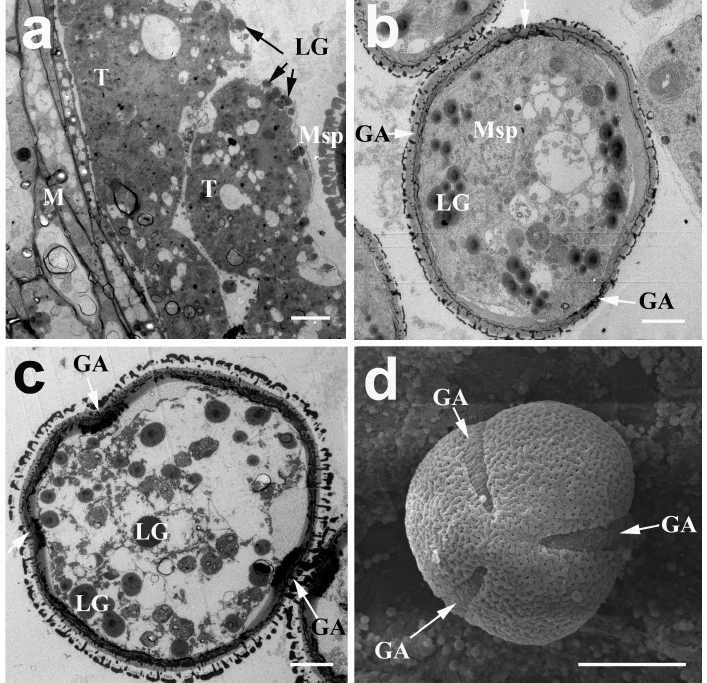
Figure 4. Transmission electron micrographs ( a – c ) and scanning electron micrographs ( d ) of the microspore and tapetum of N. nucifera ‘Honghu Hong’. ( a ) Numerous lipid granules were secreted from tapetum to the locule at the late young microspore stage. ( b ) Microspore at the middle young microspore stage. ( c ) Microspore at the late young microspore stage. ( d ) Microspore at the mature pollen stage. The arrows indicate the germination apertures in ( b – d ). GA, germination aperture; LG, lipid granule; M, middle layer; Msp, microspore; T, tapetum. ( a – c ) Bar = 5 µ m; ( d ) Bar = 30 µ